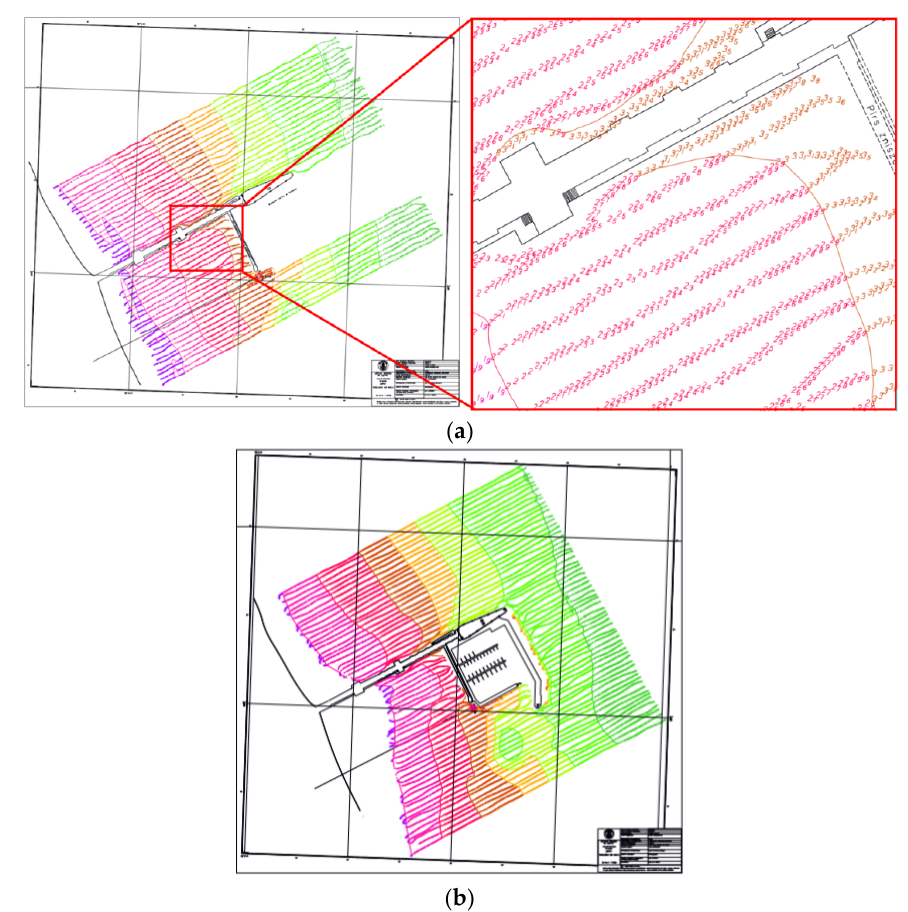
Figure 3. Bathymetric charts showing the variability in bottom relief in 2010 ( a ) and 2012 ( b ). North oriented in the scale of 1:1000